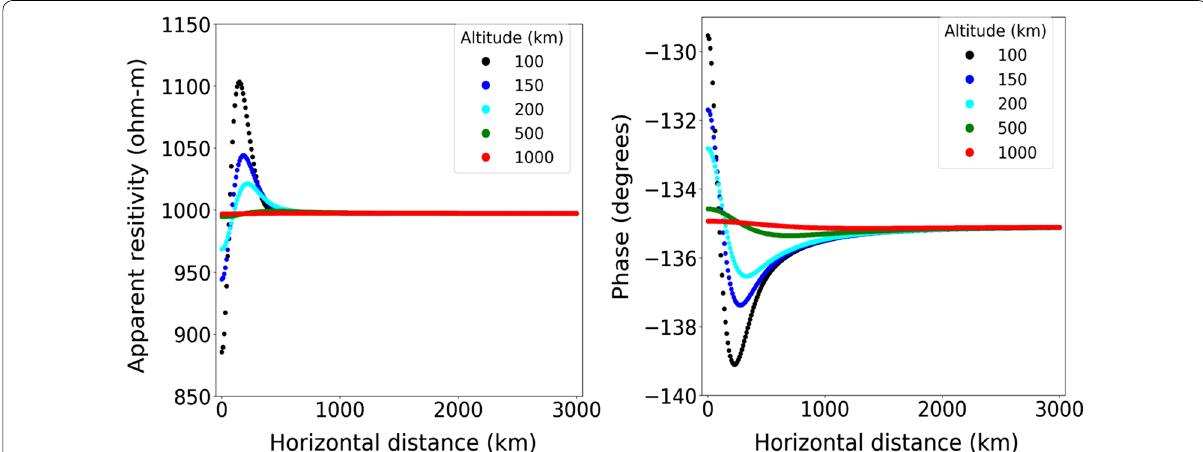
Fig. 3 MT responses at a period of 20 s: (left) relationship between the apparent resistivity and the horizontal distance of source current. (right) Relationship between the phase and the horizontal distance of source current. The black/blue/light blue/green/red circles denote the responses derived from the altitude of 100/150/200/500/1000 km, respectively